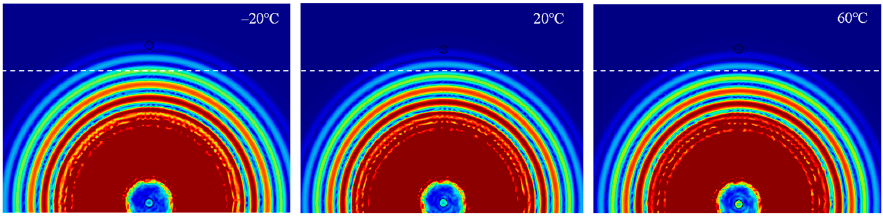
Figure 5. The effect of temperature on LW phase.